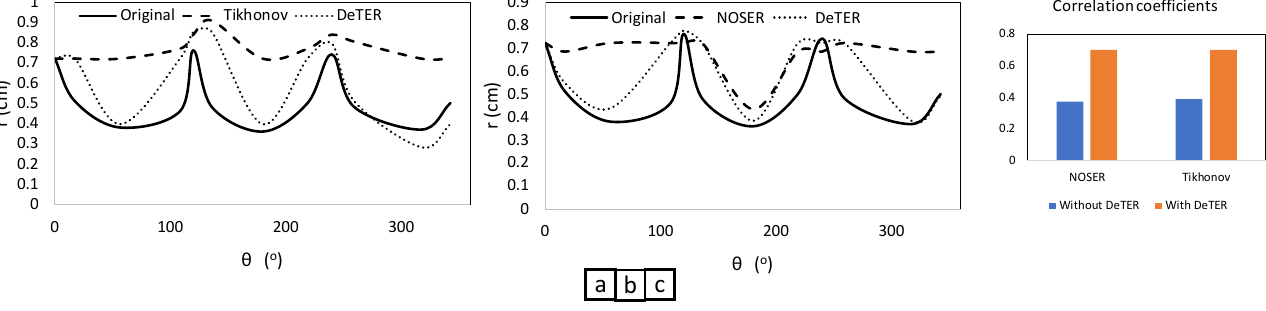
Fig.11: Shape descriptor functions for triangular target in original and reconstructed images with and without DeTER using (a) Tikhonov and (b) NOSER prior (c) comparison of correlation coefficients for (a) and